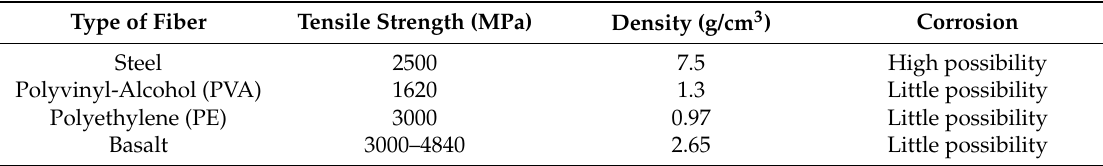
Table 1. Typical physical properties of